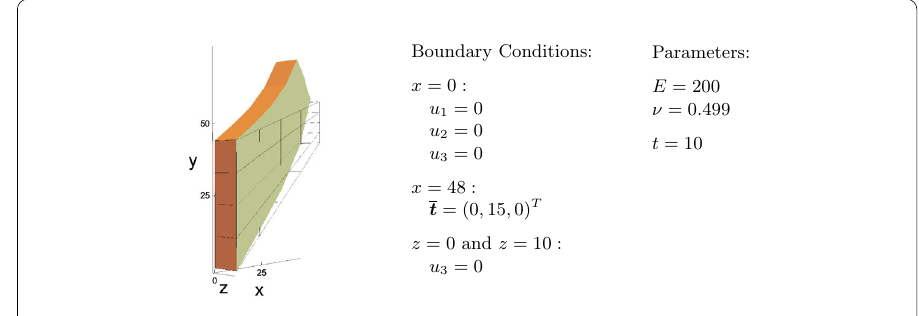
Fig. 7 Cook’s membrane problem; exemplary reference mesh and deformed body on the left and boundary conditions and parameters on the right